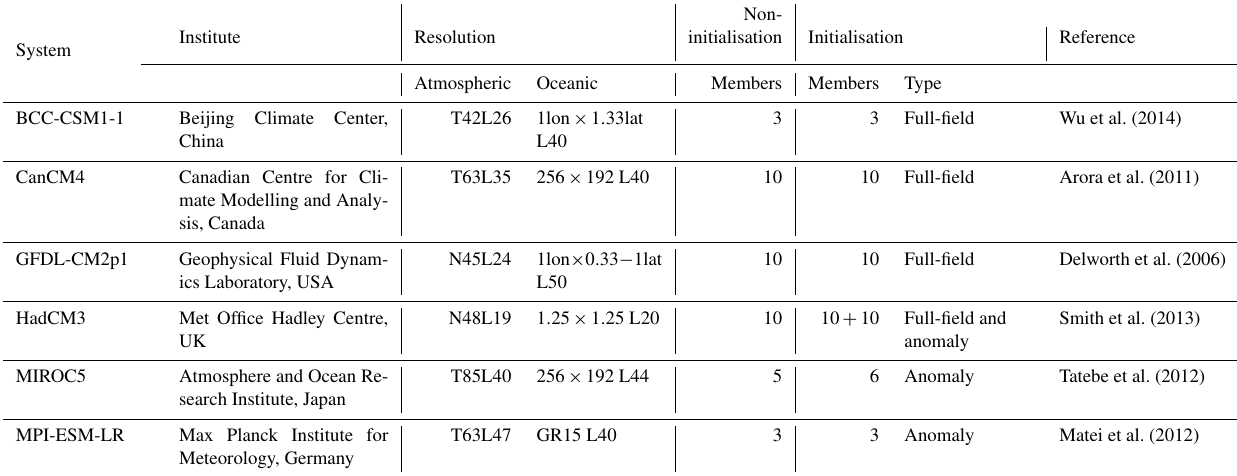
Table 1. Details of the prediction systems investigated in this